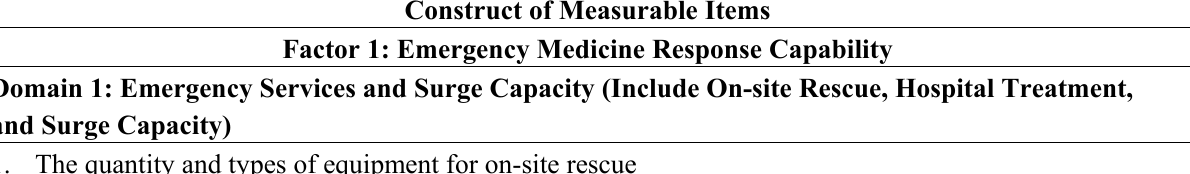
Table 2. Validated framework for evaluating hospital disaster resilience (adapted by the authors from